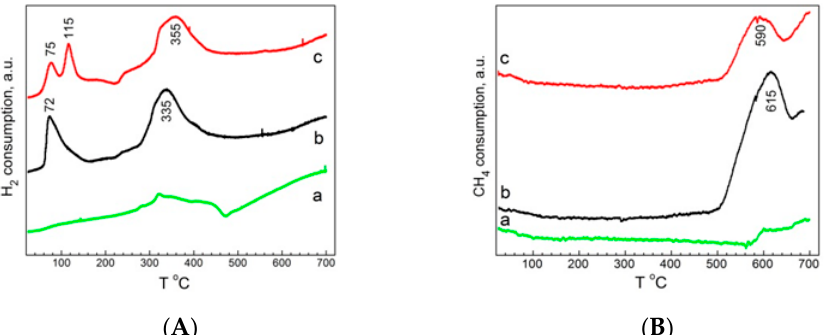
Figure 4. H 2 -TPR ( A ) and CH 4 -TPR ( B ) curves for LMO/Imp (a); Pd-LMO/Imp (b) and Pd-LMO/U-AACVD (c).